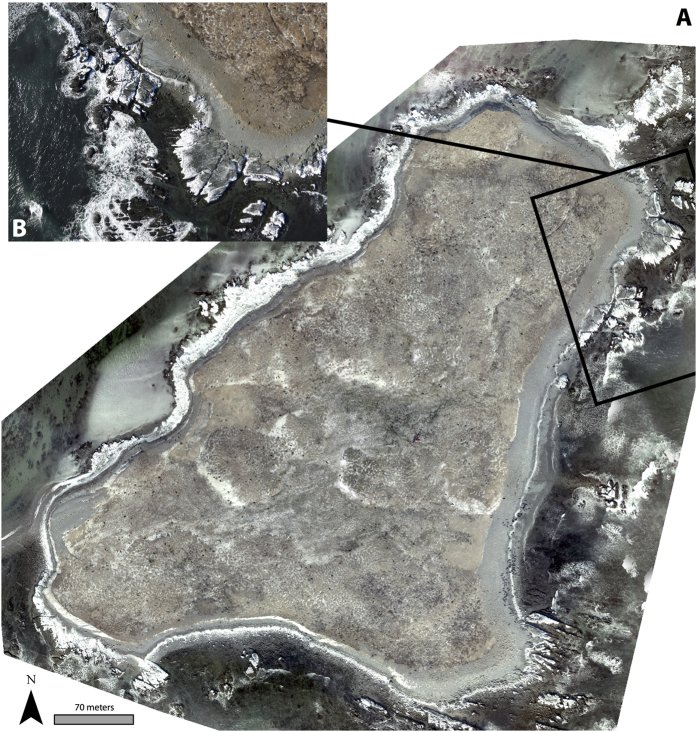
An RGB orthomosaic (A) and a representative individual RGB image (B) of the grey seal colony at Hay Island, NS Canada. This footrprint of the individual image is projected onto the orthomosaic, providing a detailed view of adult and YOY grey seals and the habitats surveyed (rock, beach and frozen ground). This map was created with ArcMap GIS software (version 10.4.1, Esri Inc.).